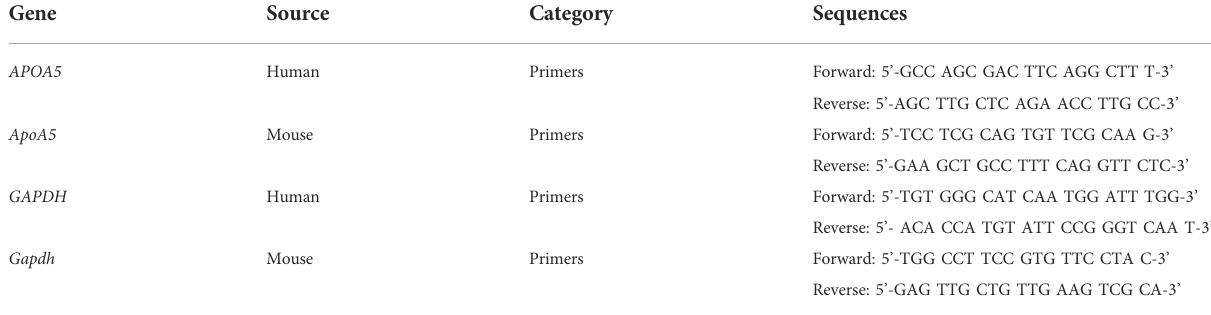
TABLE 1 Oligonucleotide sequences of primers for APOA5/ApoA5 and